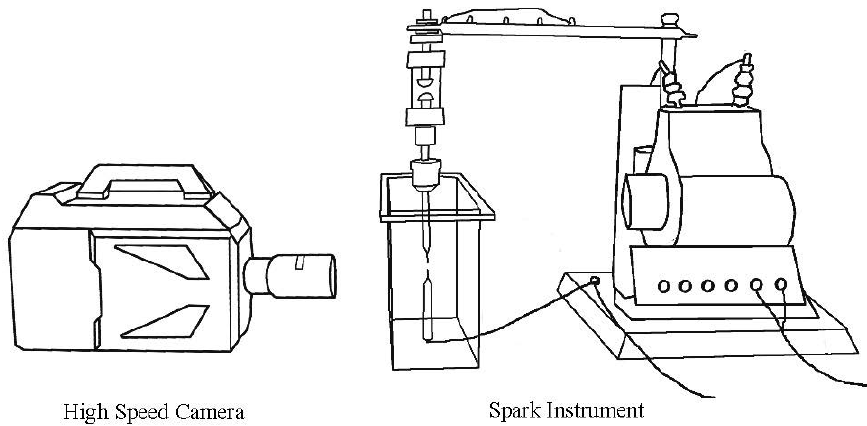
Figure 2. A line drawing of the high-speed camera and the experimental system.